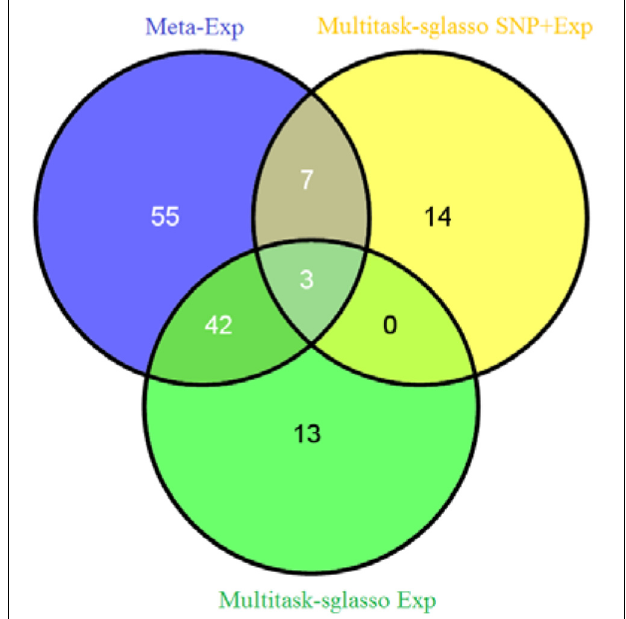
FIGURE 3 | The Venn diagram of identified genes by three methods: meta-analysis on EXP-19 and EXP-80 datasets, multitask-sglasso on all three expression datasets and multitask-sglasso on all gene expression and SNP